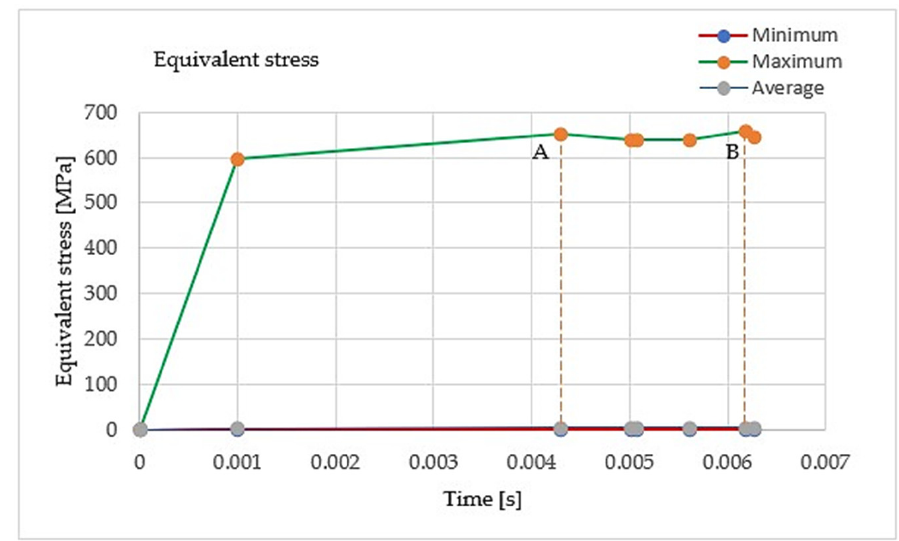
Figure 12. Diagram of equivalent stress (von Mises). Table 5. Equivalent stress (von Mises).